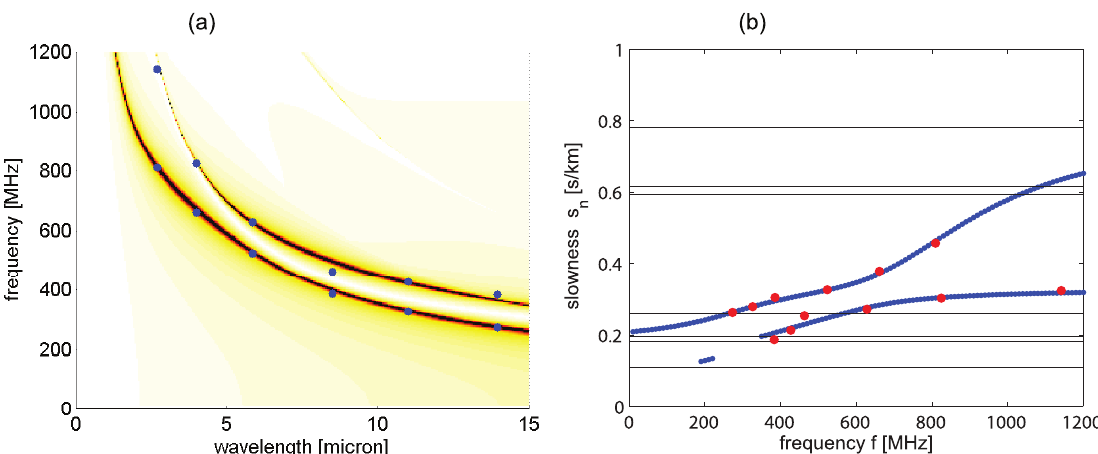
Figure 9. Experimental points (bold dots), | K 33 | level-line image ( a ) and slowness dispersion curves ( b ); “ pyramidal ” sample Figure 2.